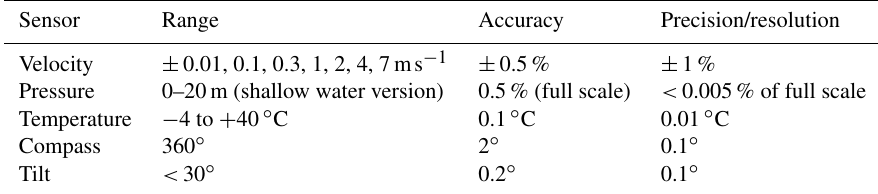
Table A3. Specifications of the NORTEK Vector acoustic Doppler velocimeter used in this